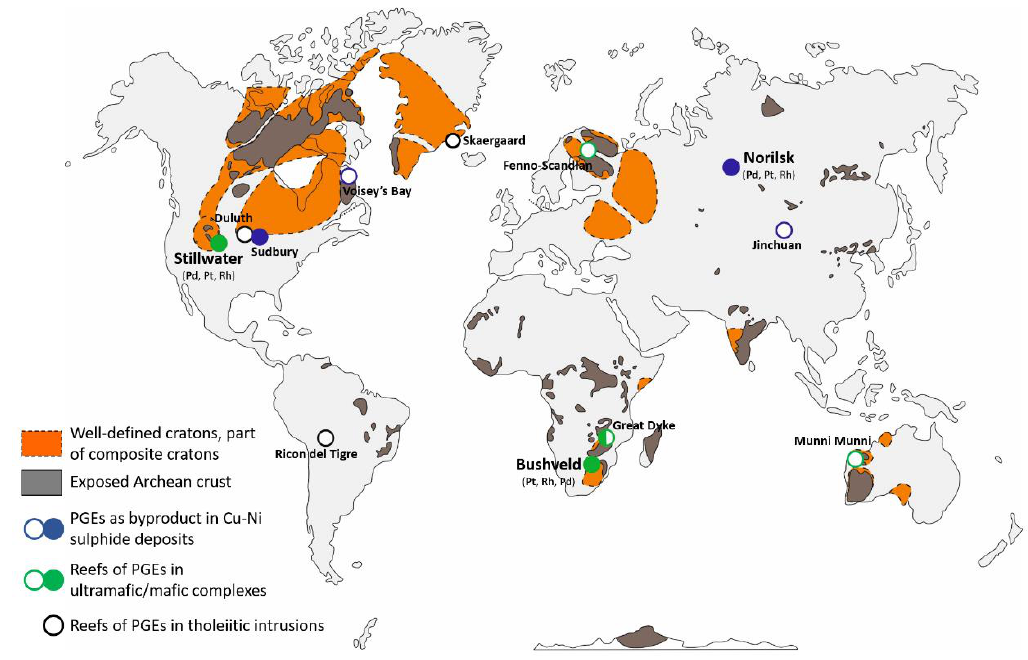
Figure 1. Worldwide deposits of PGEs; geological linkage to cratons and the types of deposits, indicating the main locations with corresponding PGEs [1,17,20,29,30].